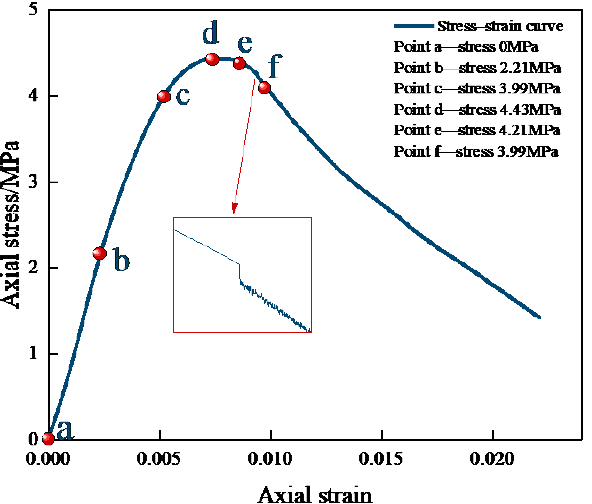
Figure 7. Selection of characteristic points of stress–strain curves under uniaxial compression for sandstone–CGFB composite samples.